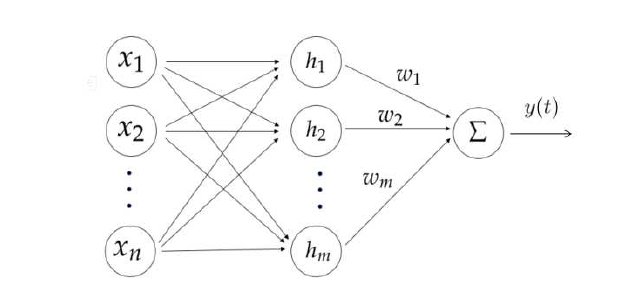
Figure 1. The radial basis function (RBF) network